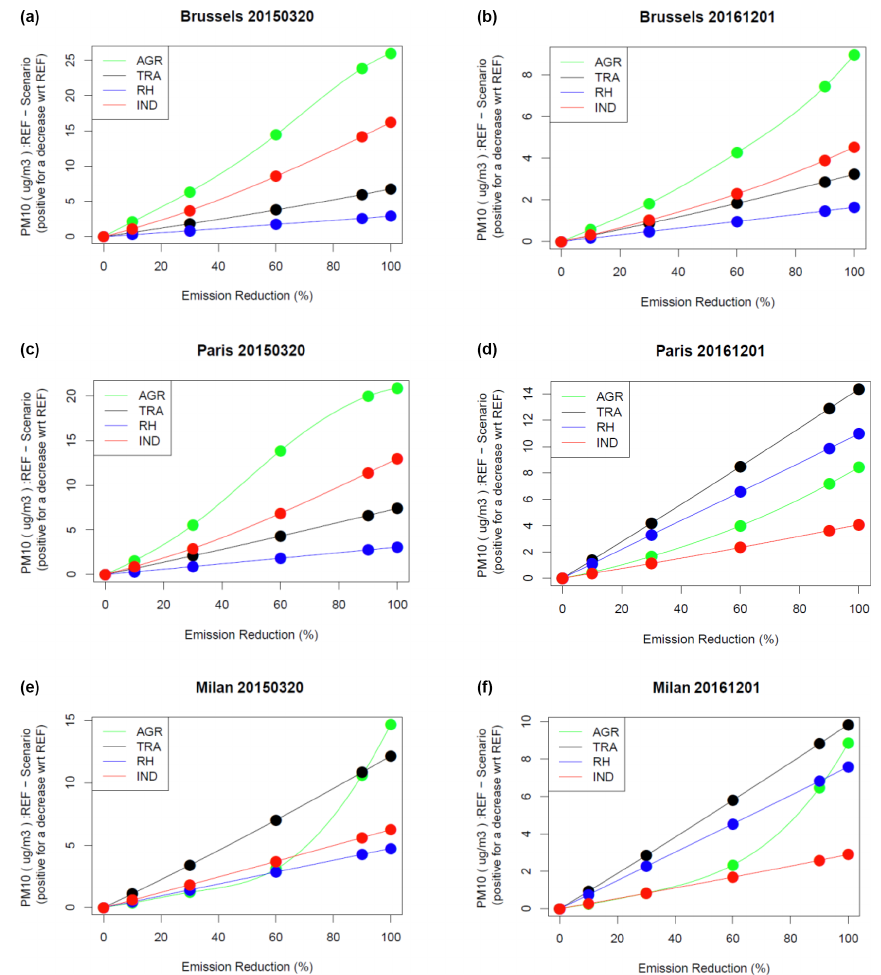
Figure 1. Modelled PM 10 reduction ( y axis: positive for a decrease with respect to the reference, µgm − 3 ) for a given reduction in agri- culture (green), industrial (red), residential heating (blue) and traffic (black) emissions ( x axis: in %) in Brussels, Paris and Milan and for 20 March 2015 (a, c, e) and 1 December 2016 (b, d, f)